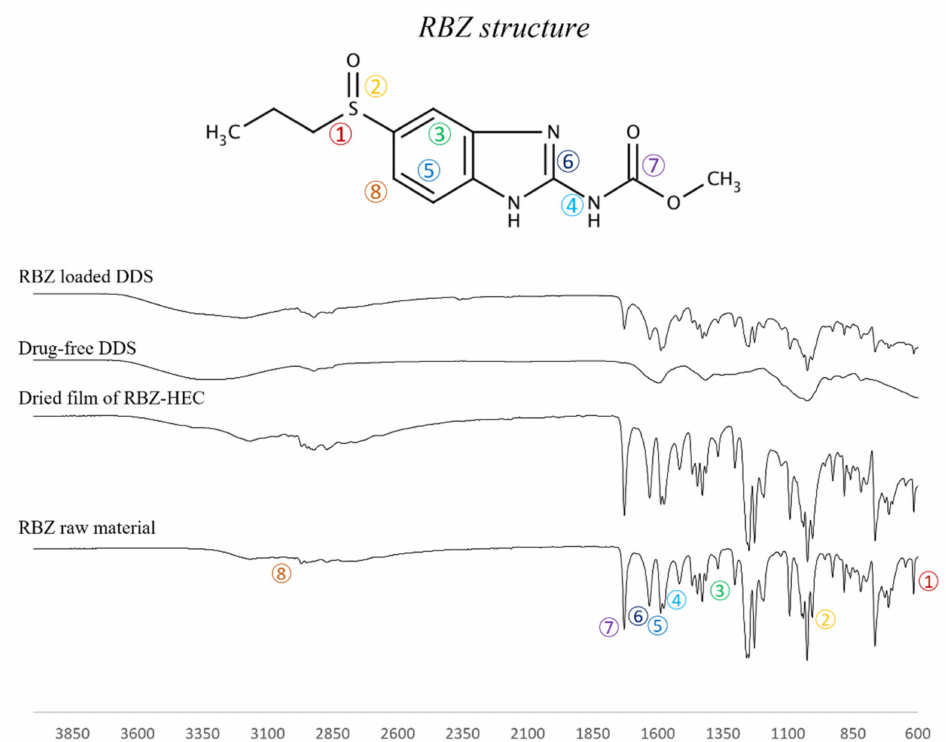
Figure 3. FT-IR spectrum of RBZ raw material, dried film obtained from RBZ-HEC gel, drug-free DDS and RBZ loaded DDS; RBZ structure, with schematic representation of the chemical bonds, was reported to allow for data